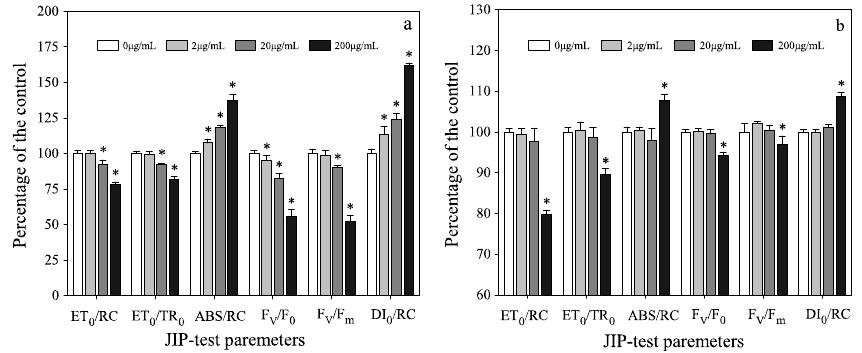
Figure 2. Changes in JIP-test parameters (compared to the control of the same species, and displayed as the percentage of the control) at different concentrations of phenol: ( a ) M. aeruginosa and ( b ) C. pyrenoidosa . The significant difference compared to the control is indicated as * ( p < 0.05).